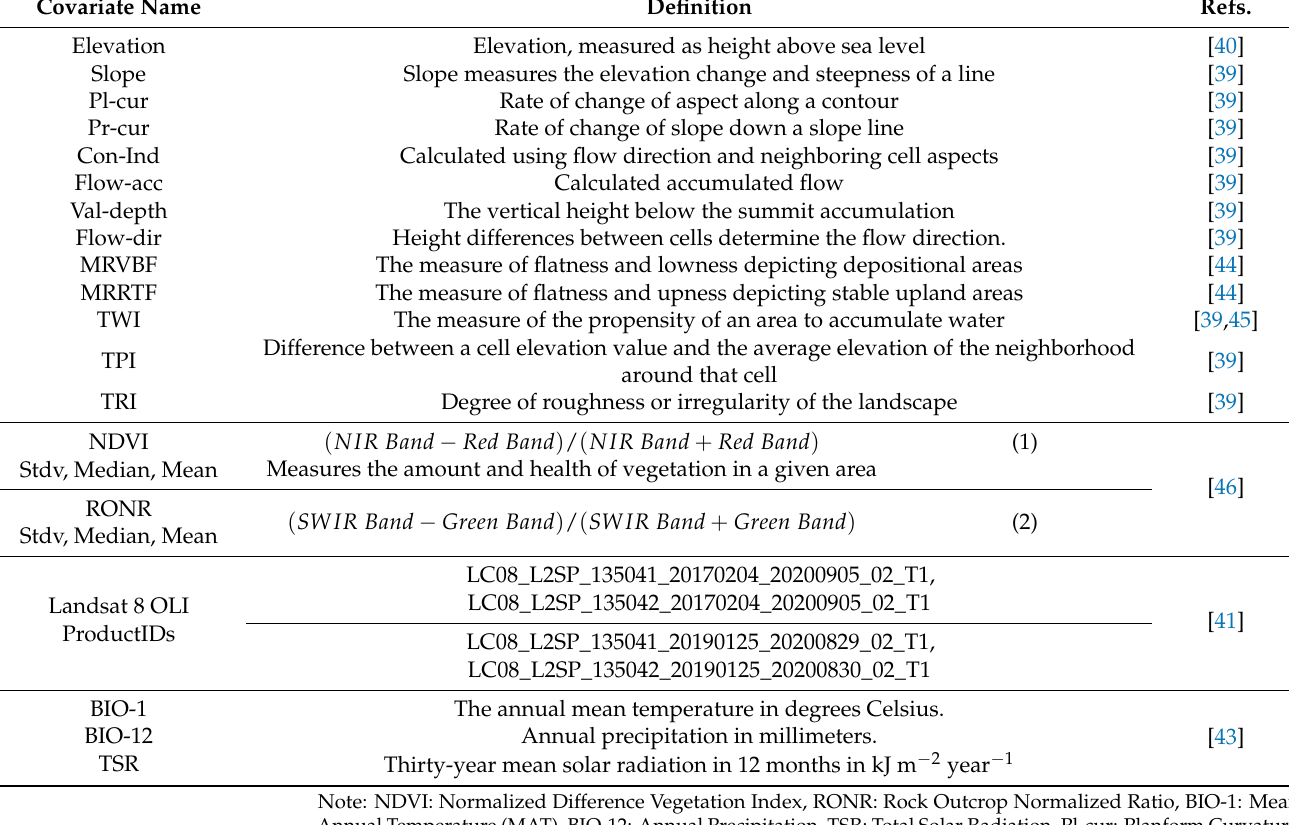
Table 1. Digital covariates used for estimating soil cation exchange